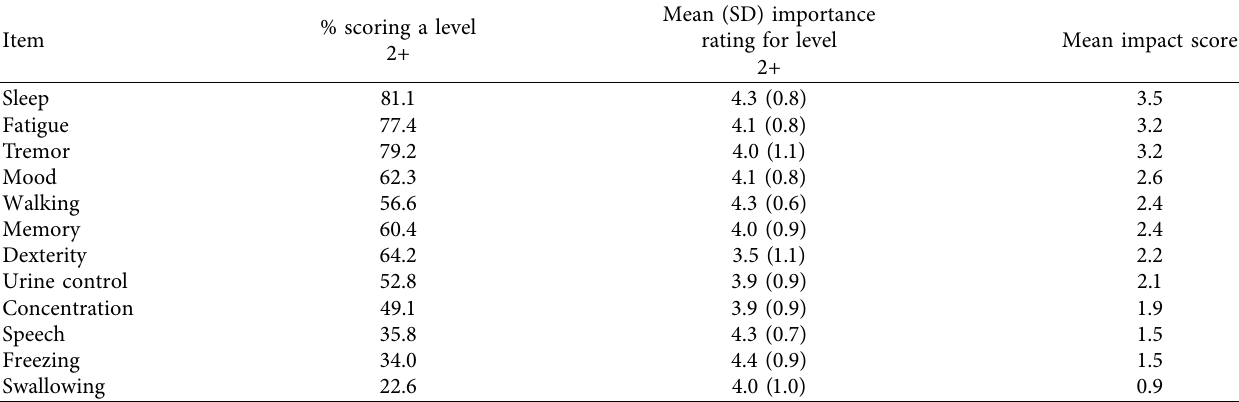
Table 2: Impact score of each item on the PB-PDI ( n � 53) for those scoring a level 2 or higher.